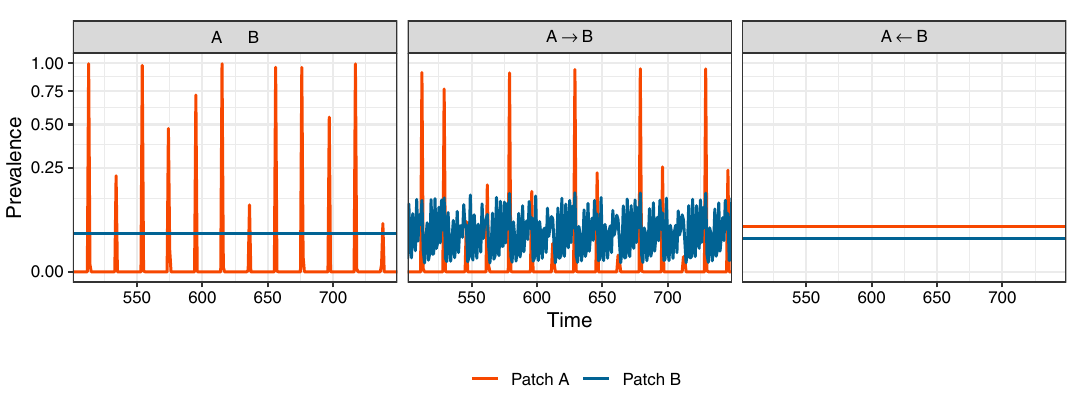
Figure 1. Connecting multiple patches with the same parameters and initial conditions results in reduced peak pathogen prevalence and dampened oscillations in patches further down the chain. Here, patches are connected such that A → B → C → D . Each panel indicates the prevalence (i.e., the proportion of the patch population currently infected with the pathogen) over time in that particular patch. Because all patches have the same parameters and initial conditions (see Methods), all patches would have the same dynamics (i.e., cycles, as seen in 49 ) in the absence of movement between patches. Thus, all differences between patch time series are due to immigration from and emigration to other patches in the chain. Note also that completing the circle (such that A → B → C → D → A ) would again make all patches identical, removing any distinction between origin and destination patches. Transient dynamics are omitted from the time series for clarity.